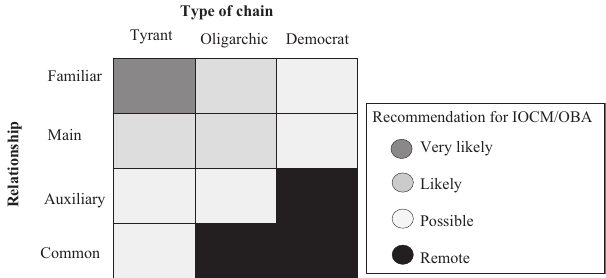
Figure 1. Analysis matrix